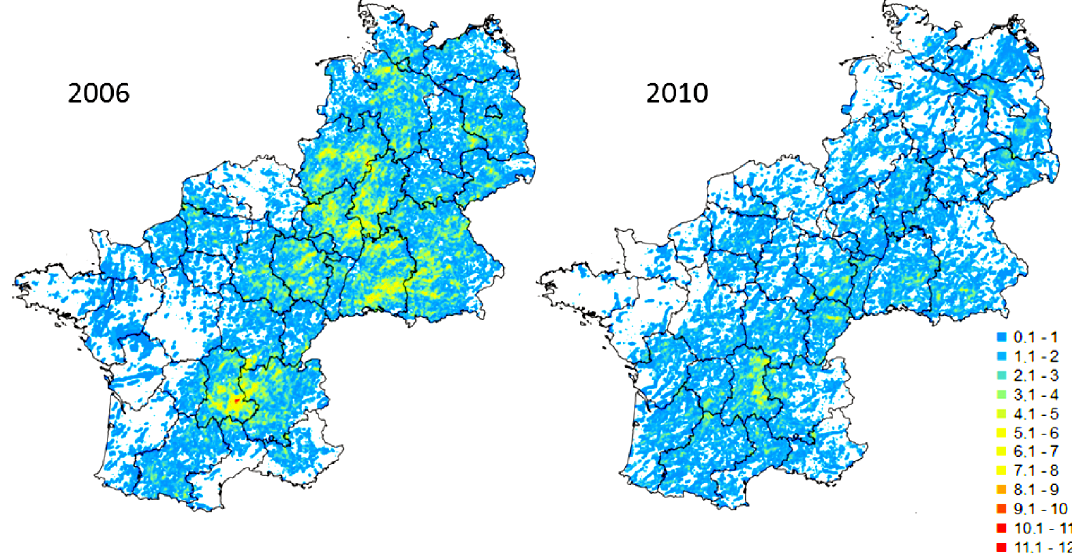
Figure 6. Number of radar-derived hail days shown for the years with the highest (2006, left) and lowest (2010, right) hail day frequency.